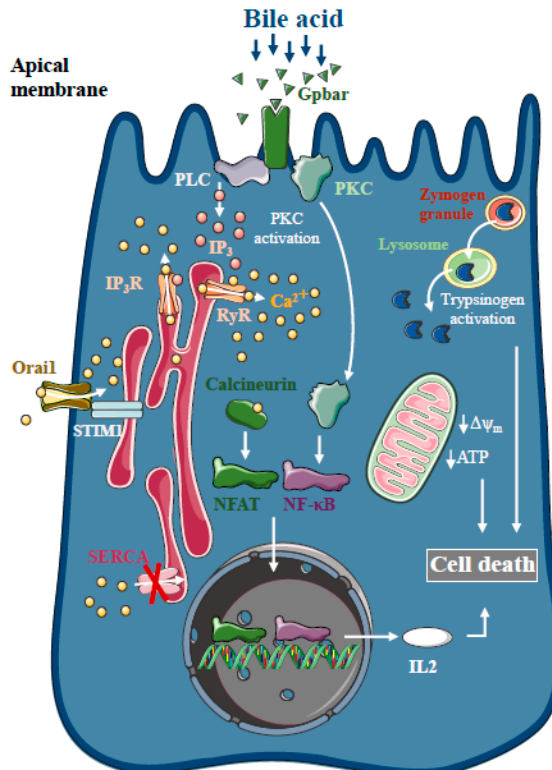
Figure 1. Intracellular Ca 2 + signalling in biliary acute pancreatitis. Bile acids dose-dependently release Ca 2 + from intracellular stores via activation of IP 3 and ryanodine receptors (RyR). The inhibition of the sarco-endoplasmic reticulum Ca 2 + pump (SERCA) and activation of Orai1-mediated extracellular Ca 2 + influx contributes to the sustained global Ca 2 + signals. Bile acids can activate the G-protein-coupled cell surface bile acid receptor (Gpbar) at the apical membrane of pancreatic acinar cells that also release Ca 2 + from the endoplasmic reticulum. Mitochondrial Ca 2 + overload can lead to mitochondrial damage by opening the mitochondrial permeability transition pore and dissipating the mitochondrial membrane potential. In addition, bile acids have been demonstrated to activate calcineurin in a Ca 2 + -dependent manner in pancreatic cells, leading to premature digestive enzyme and NF- κ B activation.